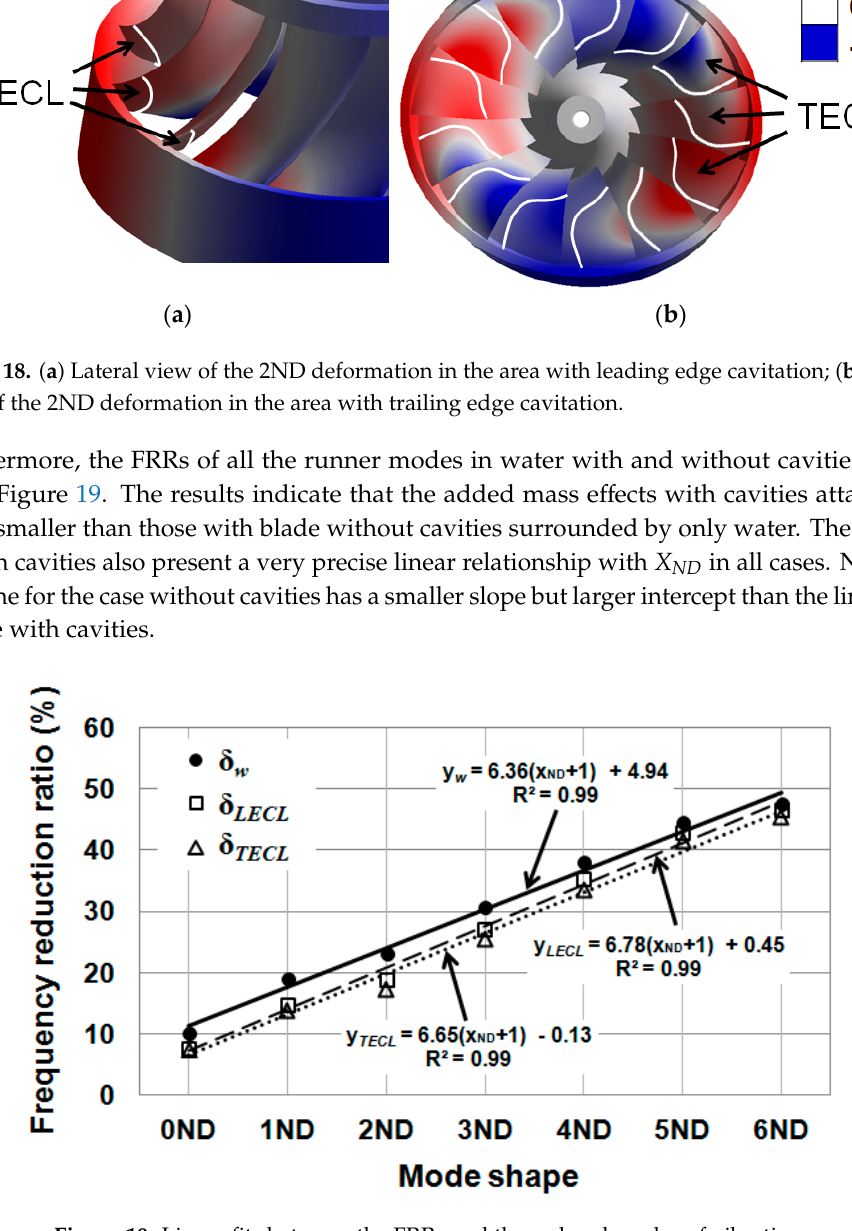
Figure 19. Linear fits between the FRRs and the ordered modes of vibration.